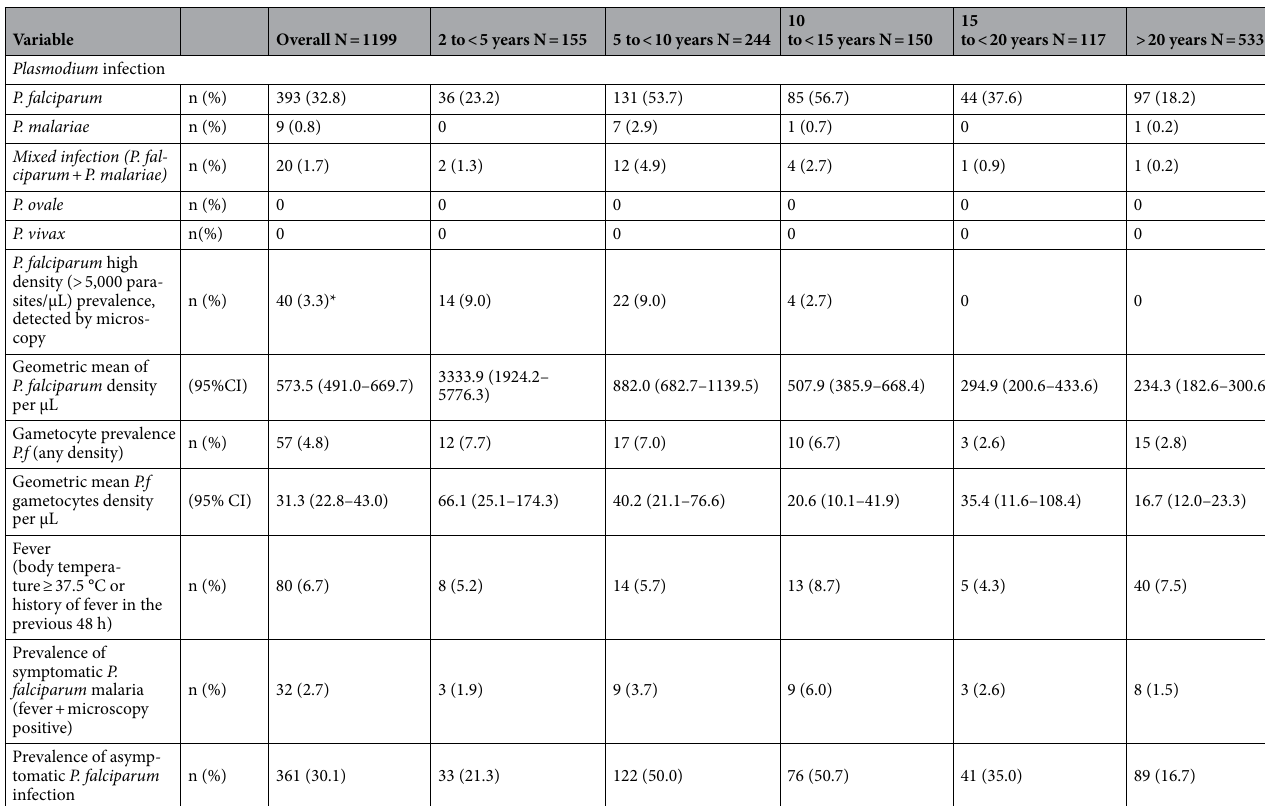
Table 2. Parasitological characteristics of cross-sectional survey participants. *2/40 were mixed P.f / P.m infections.